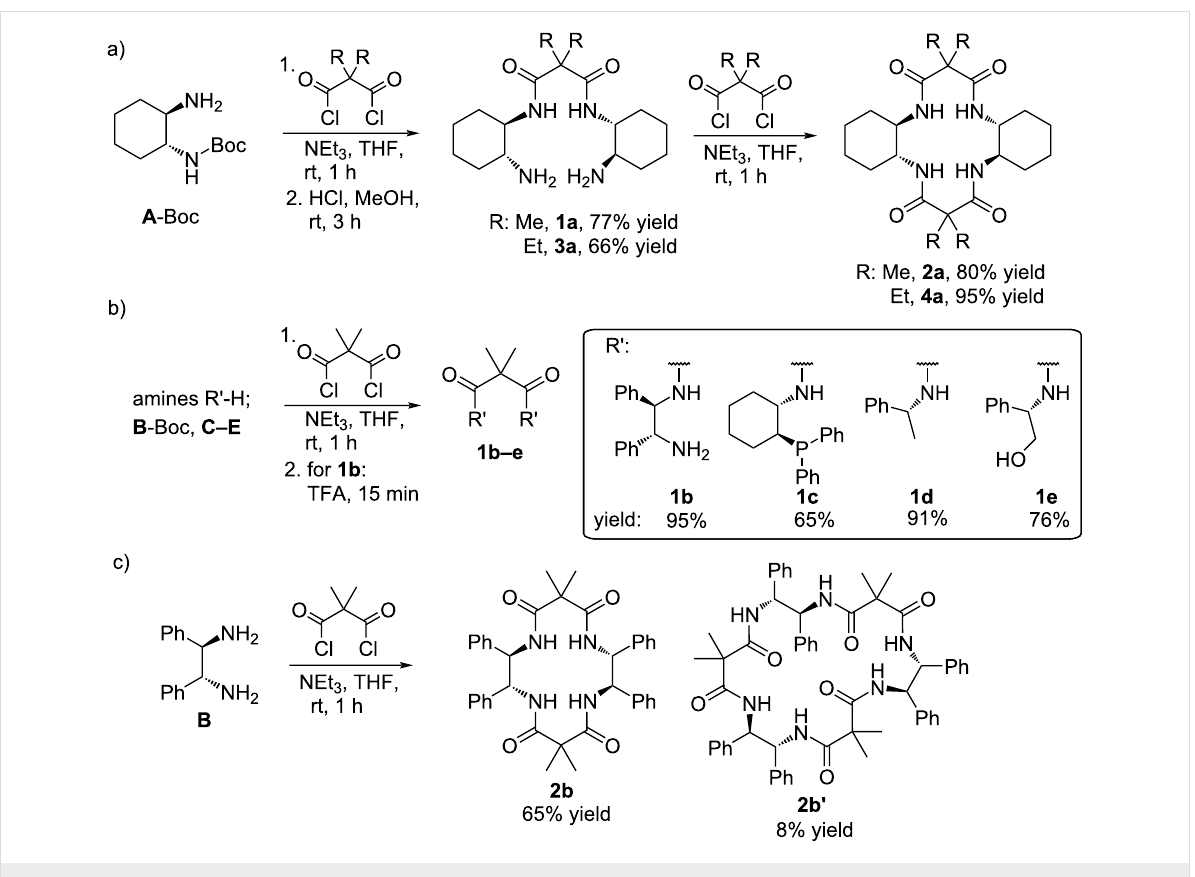
Scheme 1: Synthetic protocols for the preparation of potential ligands 1 – 4